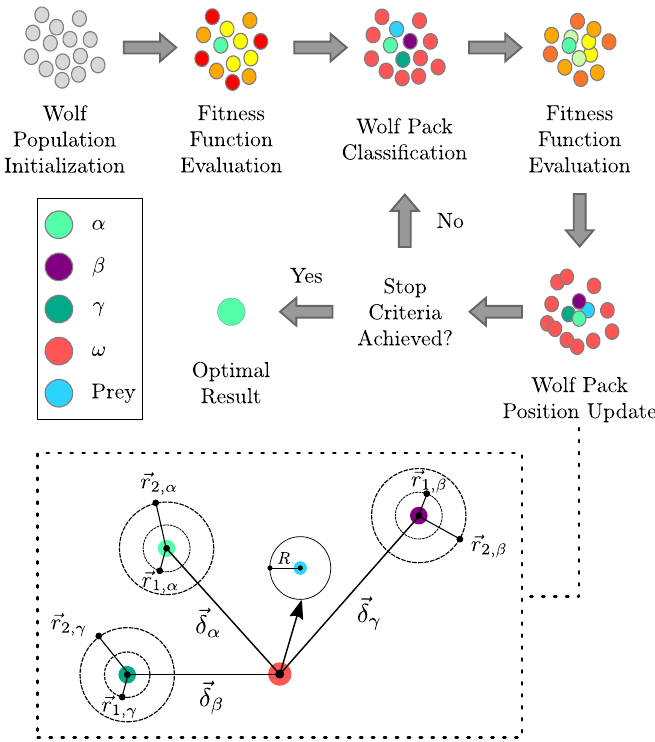
Figure 5. Illustrative procedure of Gray Wolf